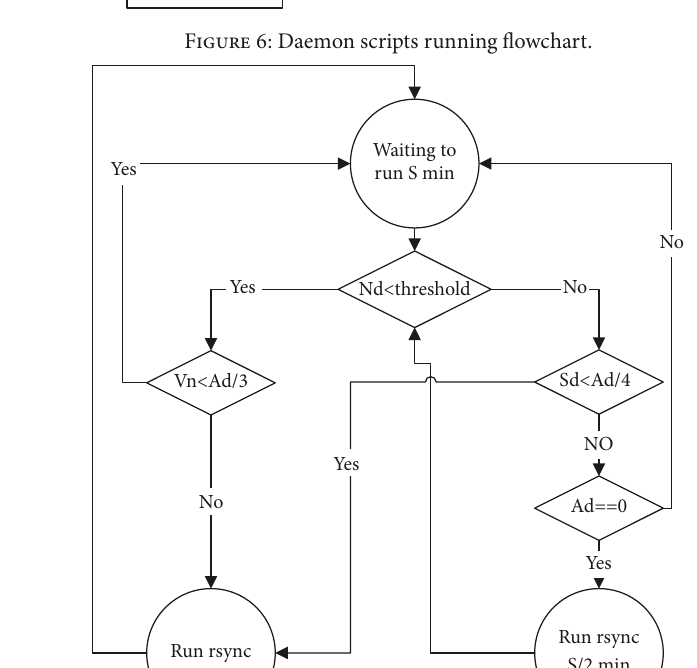
Figure 6: Daemon scripts running flowchart.